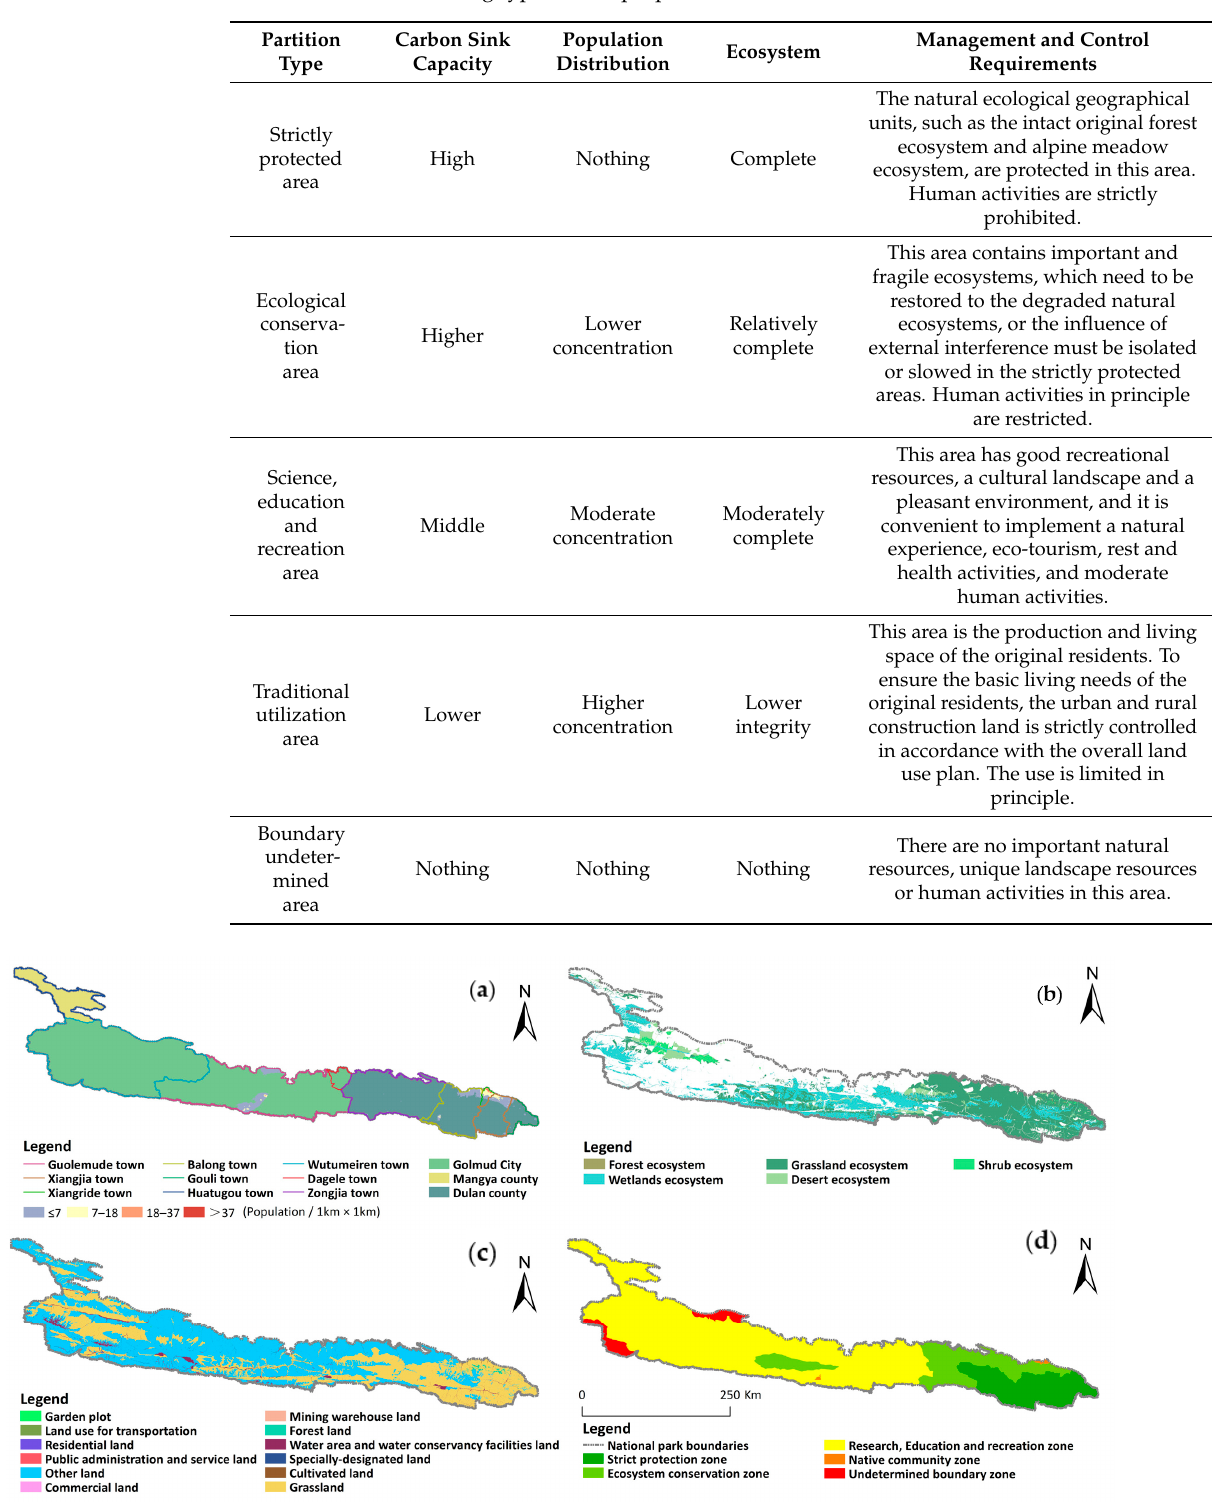
Table 2. Functional zoning types of the proposed Kunlun Mountain National Park.